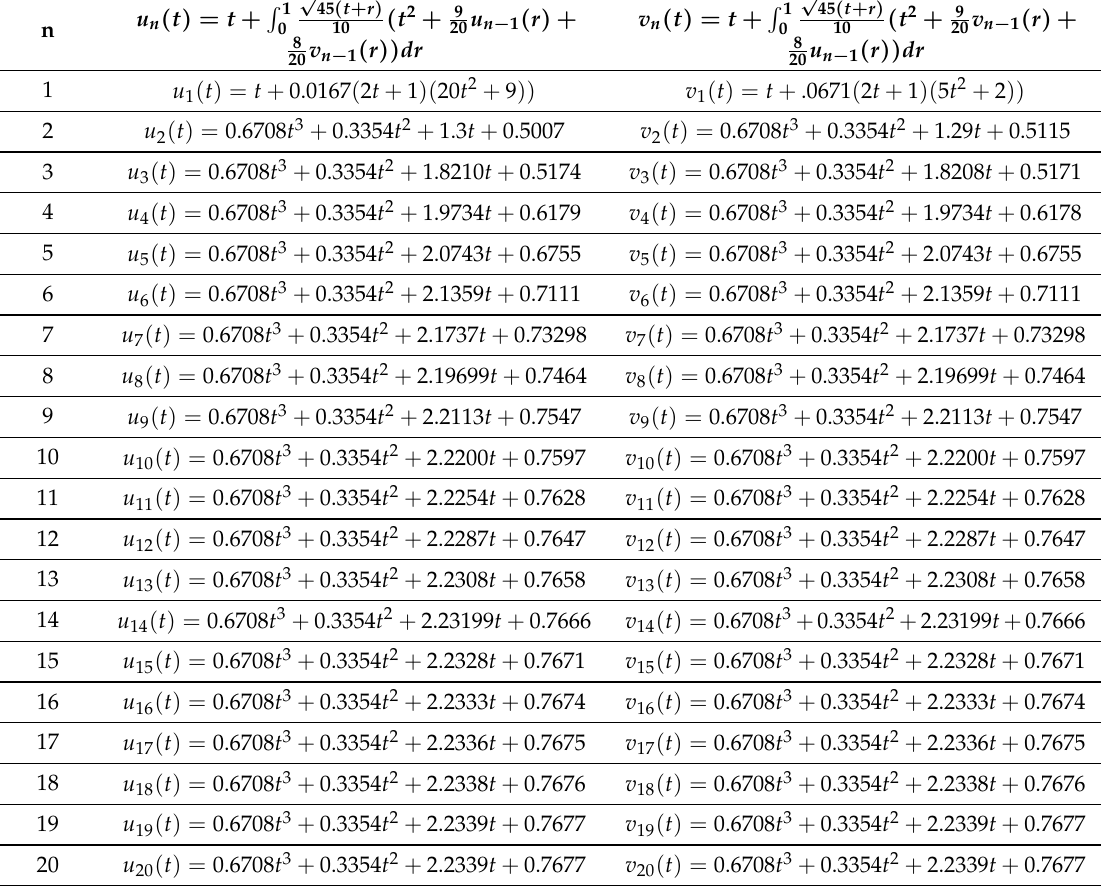
Table 1. Convergence of sequences < u n ( t ) > and < v n ( t ) >